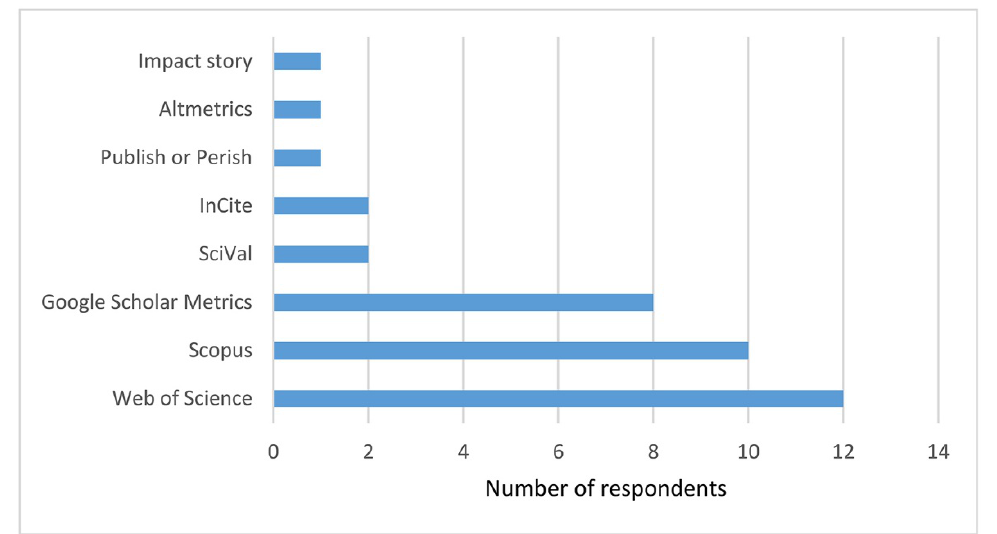
Figure 3 Resources for research impact